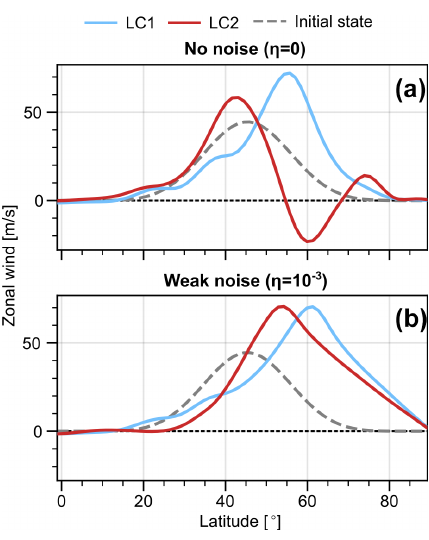
Figure 4. Zonal mean zonal wind at 10km averaged over the final state (days 40–45) for LC1 and LC2 initial conditions without noise ( a , η = 0) and with weak noise ( b , η = 10 − 3 ). Dashed profiles show the corresponding winds of the initial conditions.